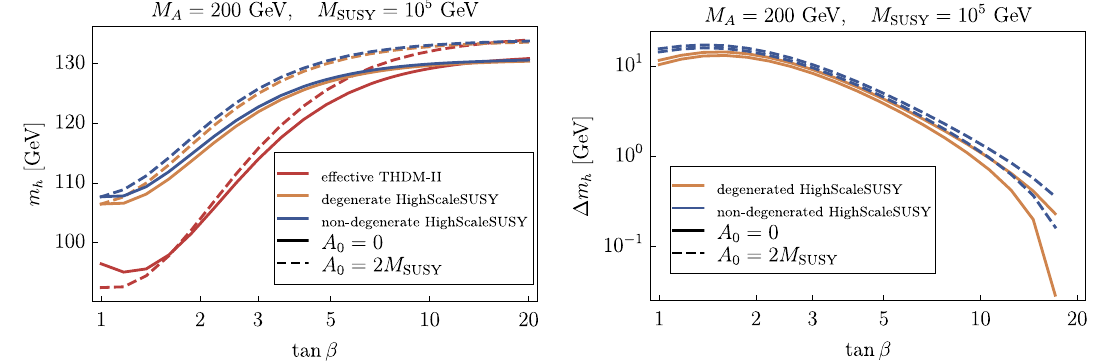
Fig. 10 The Higgs boson mass prediction as function of tan β for a high-scale SUSY scenario with low M A and two different values of A 0 . The blue lines show the results for a proper matching of the MSSM to theTHDM-II. Thegreenlinescorrespond tothematchingoftheMSSM